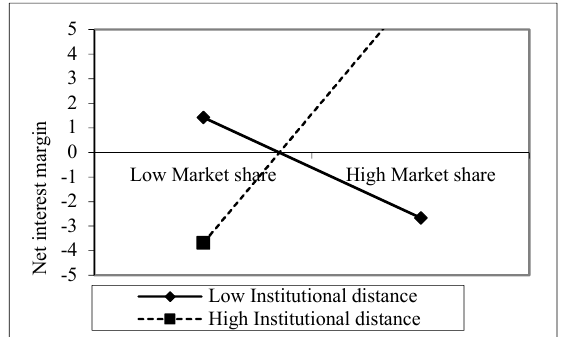
Figure 2. Market Share × Institutional Distance.